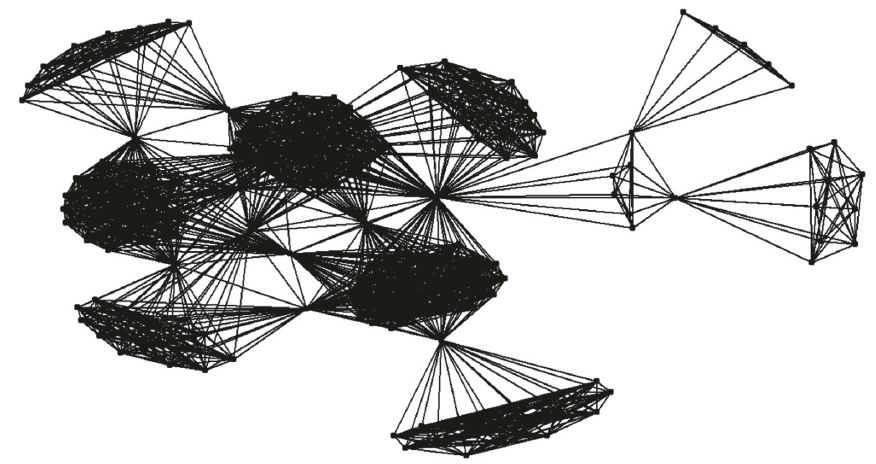
Figure 2: Space P spatial model of Nanjing metro complex